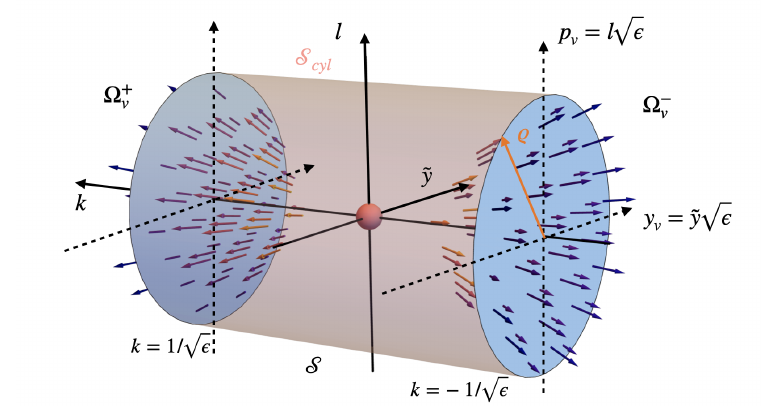
Figure 6: Parameter space and phase space for ray tracing . A Berry monopole is located at the origin of ( k , l , ˜ y ) -parameter space, which corresponds to a degeneracy point for the eigenvalues of matrix H . Phase space for ray tracing associated with k the scalar wave operators ˆ Ω ± are recovered in the semi-classical limit ε → 0, with the ) given in (59). The surface S in parameter change of variable from ( l , ˜ y ) to ( p , y v v space is a cylinder where both circular ends are delimited by closed phase space (cid:112) ε trajectories of radius ϱ at positions k = ± 1 /